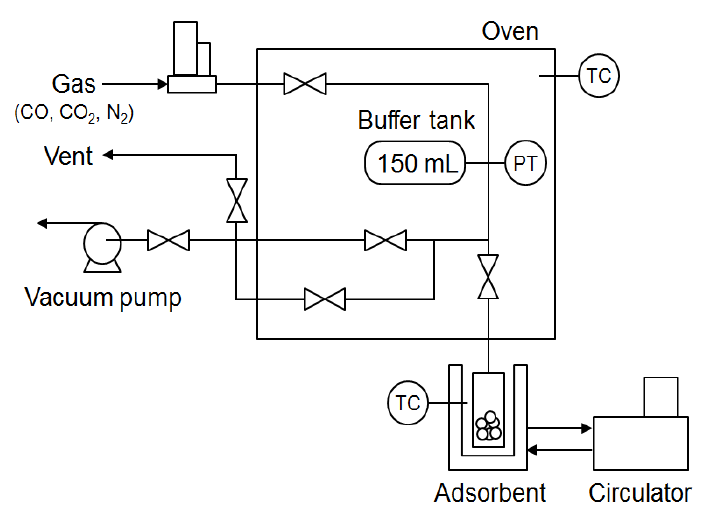
Figure 1. Schematic diagram of the experimental set up used for measurement of CO adsorption capacity on adsorbents (PT: pressure transmitter; TC: thermocouple).